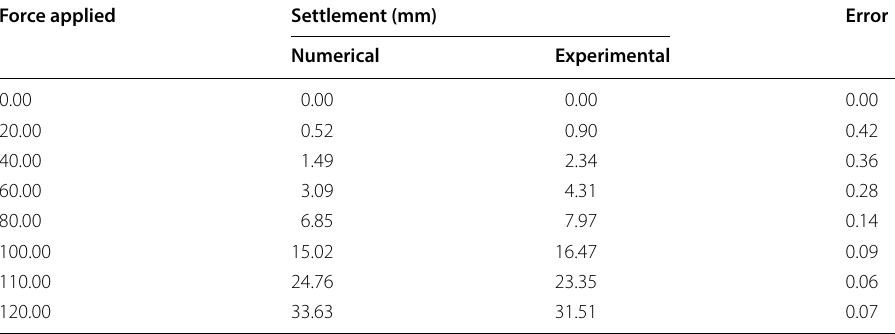
Table 5 The difference between numerical and experimental settlement for a half-length encased stone column in a sandy